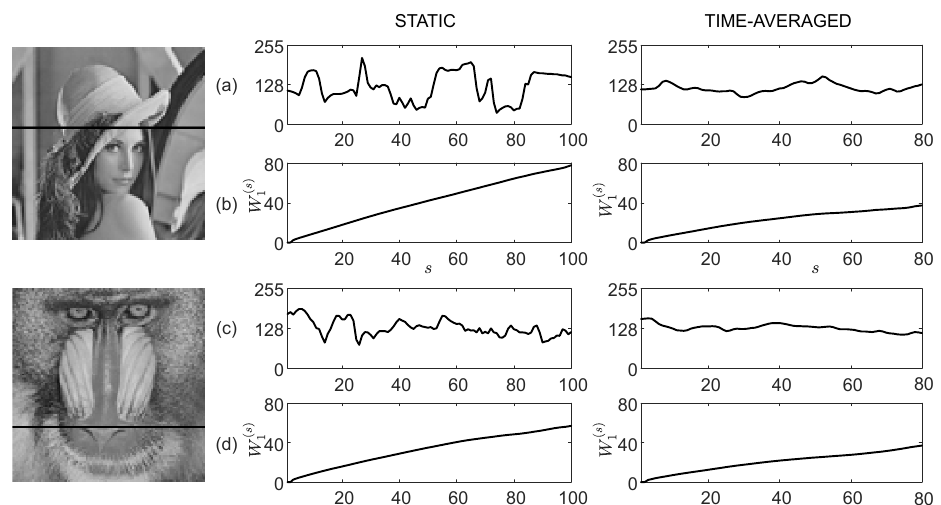
Figure 5. The motion-induced blur decreases the contrast of the digital image. Two horizontal sections of the Lena [37] and the Baboon [38] digital images are denoted by black lines in the left column. The variations of the brightness of pixels in the section of the static Lena image and the time-averaged Lena image (the amplitude of oscillations is set to 10) are depicted in panel ( a ). The variations ( s ) of W with respect to s in both one-dimensional images are shown in panel ( b ) ( ω 1 ( Lena ) = 37.3). The variations of the brightness of pixels in the section with the static Baboon image ω max and the time-averaged Baboon image (where the amplitude of oscillations is set to 10) are depicted ( s ) in panel ( c ). The variations of W with respect to s in both one-dimensional images are shown in 1 ( Baboon ) = 57.1, ω ( Baboon ) = 37.1). Note that one-dimensional images are very different in panel ( d ) ( ω max max the static mode, but become similar in the time-averaged mode. The DVC scheme developed in this paper is based on a completely different optical